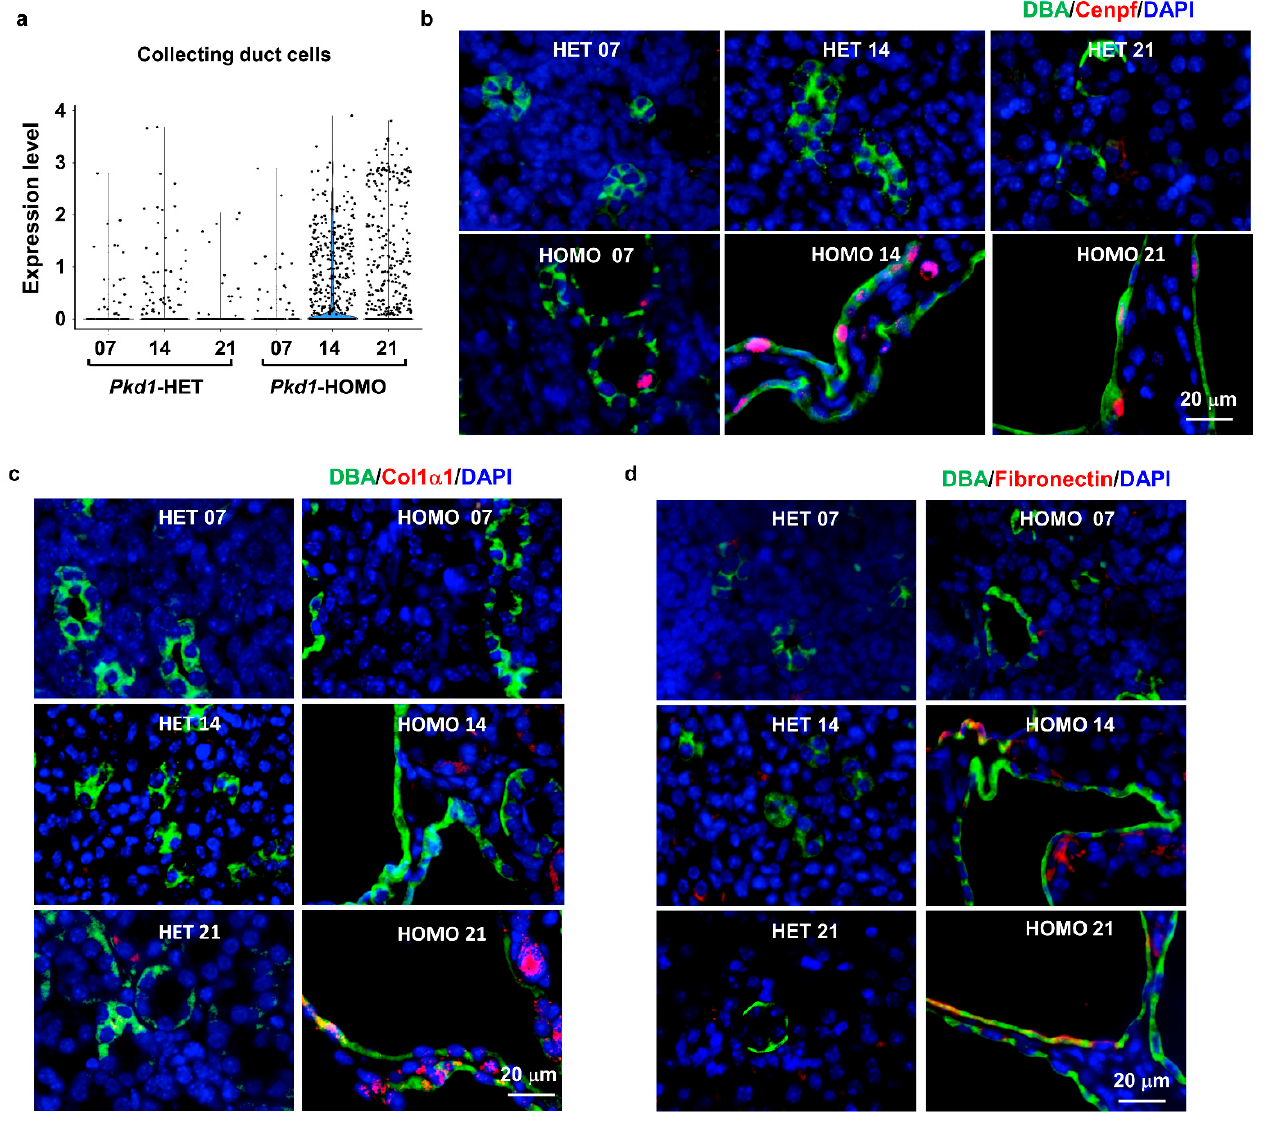
Figure 3. Expression pattern of transitional cell marker genes. ( a ) Violin plots showing the expression of Cenpf in collecting duct cells. ( b ) Representative immunofluorescence staining for Cenpf in Pkd1 heterozygous and homozygous knockout mouse kidneys. Green color labels DBA and red color indicates Cenpf. ( c , d ) Representative immunofluorescence staining for Col1 α 1 ( c ) and fibronectin ( d ) in Pkd1 heterozygous and homozygous mouse kidneys. Green color labels DBA and red color indicates Col1a1 and fibronectin, respectively.